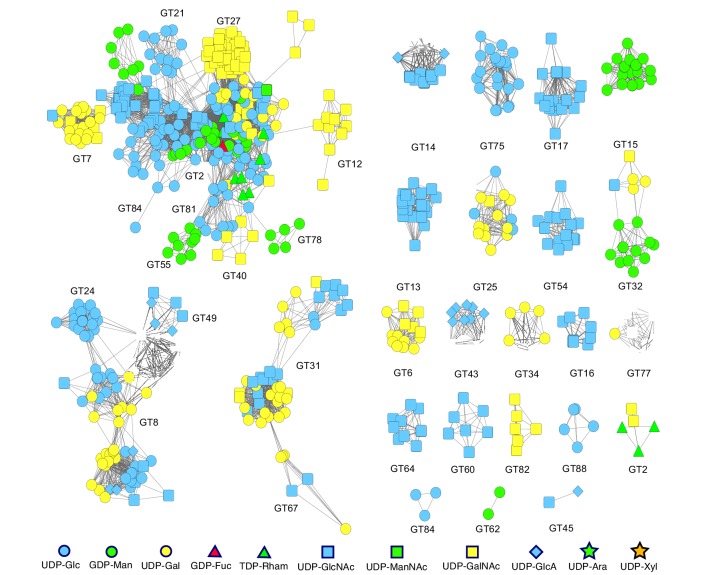
Sequence homology-based network of all the experimentally characterized sequences form the GT-A fold families.Nodes represent the sequences that were annotated as characterized and collected from the CAZy database to be used in the training dataset for ML. The color and shape of the nodes indicate the donor specificity for that sequence. An edge between two nodes indicate that the sequences are homologous with an e-value better than 1e-5. Smaller edge distance indicates a higher similarity between nodes. An edge-weighted spring embedded layout from Cytoscape was implemented to minimize edge crossings and enhance visual interpretability. At multiple locations in the network, closely related sequences differ in donor specificity, rendering prediction through similarity alone difficult.